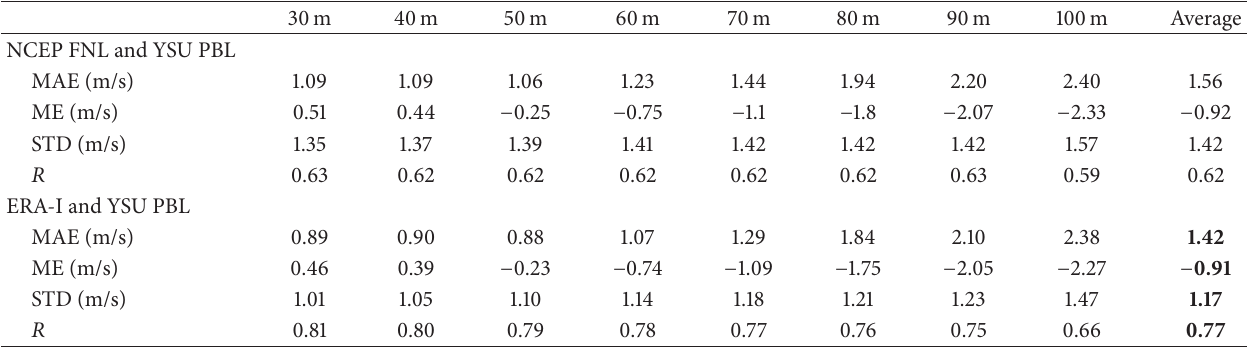
Table 3: Statistical metrics (MAE in m/s, ME in m/s, STD of the ME in m/s, and 𝑅 ) for wind speed at 8 vertical levels (30–100 m), so as to evaluate the performance of different input datasets (NCEP versus ERA-Interim) at the 3 km WRF modelling domain.